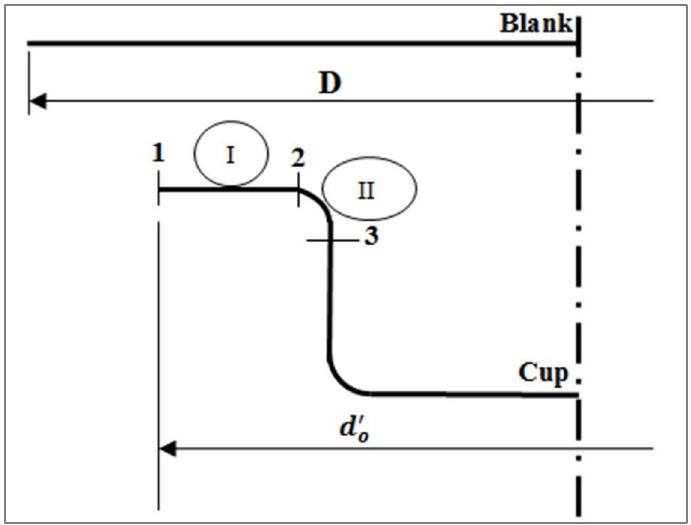
Figure 6. Flow stress zones in deep drawing at an intermediate state.